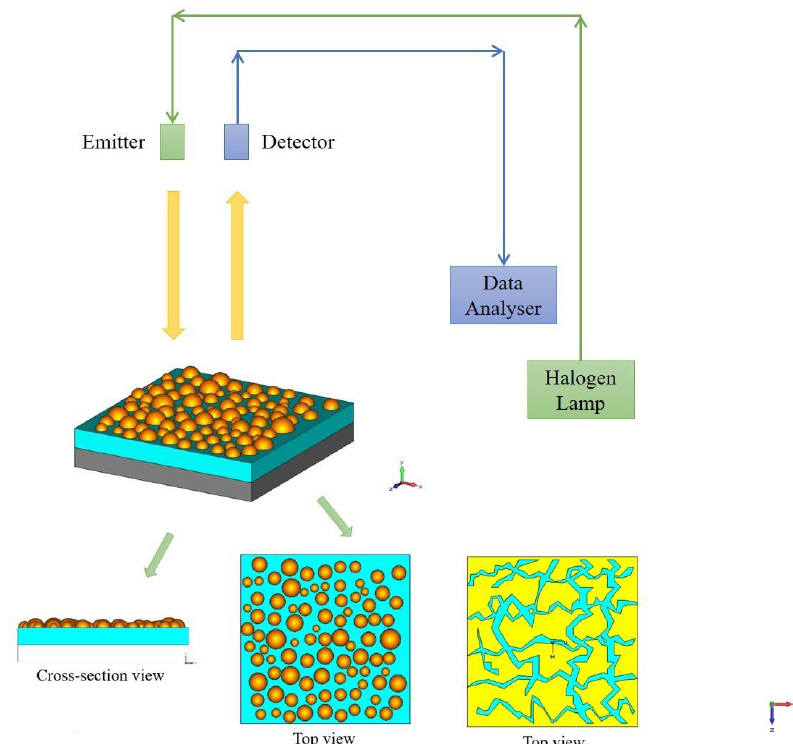
Figure 1. Schematic experimental setup for the reflectivity experiment. The tested triple layer samples consist of: A thick n-doped Si substrate (shown in grey); an insulating SiO 2 or Al 2 O 3 oxide layer with thickness of 540 nm and 60 nm, respectively (shown in cyan); and a nm-sized metal film (shown in yellow). The role of the metal nano-film on the surface of the oxide is to create effective refractive index matching between the air and the system. The morphology of the metal nano-film varies depending on the film thickness. In the thinnest Sn nano-films, the Sn metal was deposited onto a homogeneous and continuous Ge buffer layer (1 nm thick). The resulting film consists of separate droplets (see Top view left). In the thickest Nb films the morphology resembles more interconnected islands (see Top view right). The incident light is directed both perpendicular to the flat film surface and at some angles. The wavelength of the incident light is varied from near ultra-violet (425 nm) to near infrared (920 nm), completely covering all visible light frequencies.